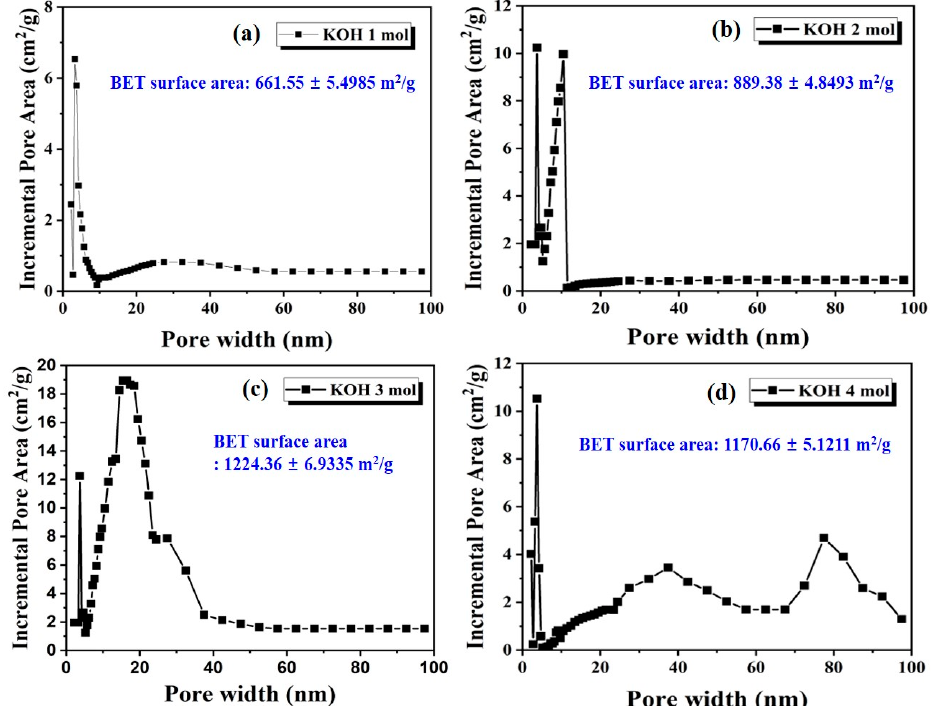
Figure 11. BJH analysis of nitrogen physisorption showing the incremental pore area distribution of activated LDPE / HDPE sheath-core carbon fibers at various KOH molarity: ( a ) 1 mol; ( b ) 2 mol; ( c ) 3 mol; ( d ) 4 mol.